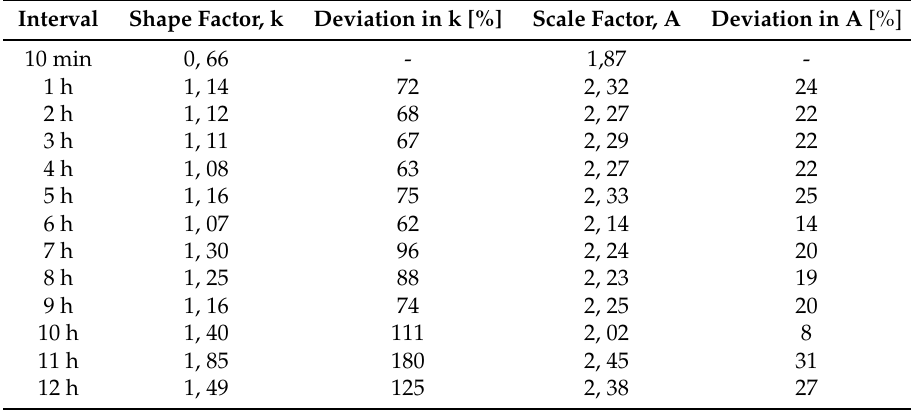
Table 1. The impact of the interval deficiency in wind speed data on the Weibull parameters, compared to wind speed data average over 10 min periods.